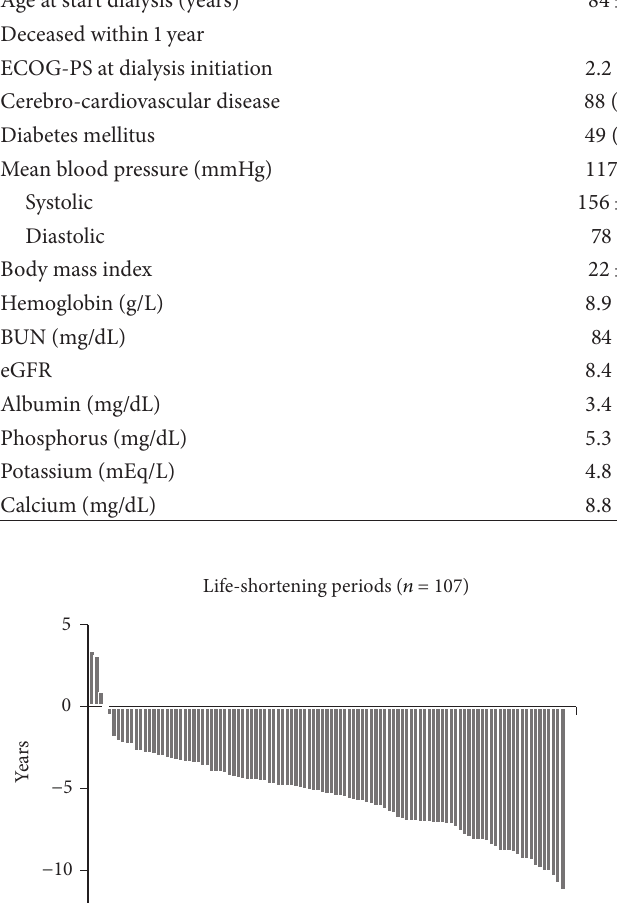
Figure 4: Life-shortening periods in dialysis patients aged ≥ 80 years. The median estimated life-shortening periods were − 5.3 years in deceased patients aged ≥ 80